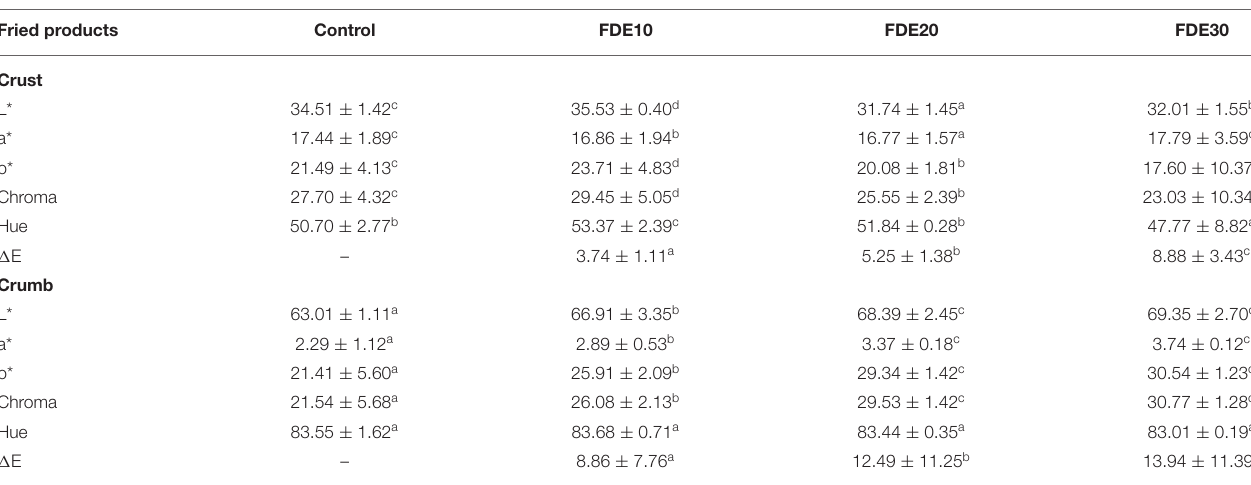
TABLE 2 | Color profile of egg-enriched fried